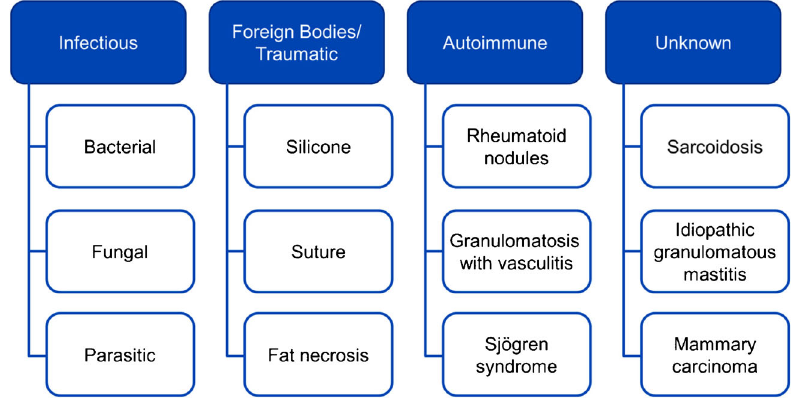
Fig. 1 Granuloma. a Diagram of a granulomatous response (with central necrosis) to a persisting antigen. Persisting antigens include microorganisms, foreign material or antigens that are unknown at this time. (Reproduced with permission) b Histologic photomicrographs